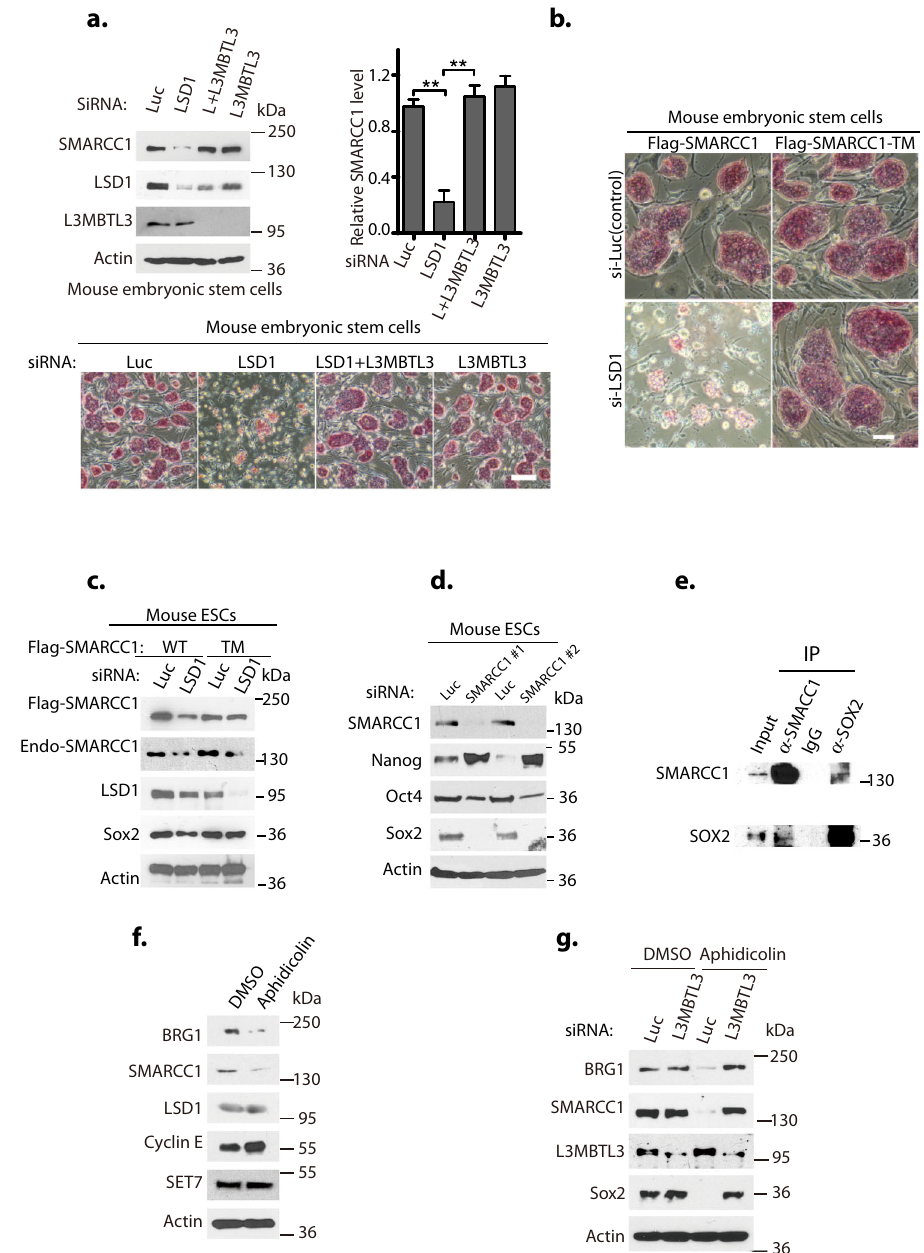
Fig.5|SMARCC1isacriticaltargetofLSD1inmouseESCs.a L3MBTL3silencing stabilizesSMARCC1inmouseembryonicstemcells.ThemESCsweretransfected with50nMof luciferase,LSD1, LSD1 +L3MBTL3,andL3MBTL3siRNAsfor40h. Representation from threeindependentexperimentsisshownforthe levelsof SMARCC1, LSD1,L3MBTL3, and actinexamined byWestern blotting and quan- titativelyanalyzed.Signi fi cancewasindicatedasatwo-tailed,unpaired, t -testfor a .Values are expressed asthe mean± SEM. ** p < 0.01. b , c The SMARCC1 triple mutant confers resistance to LSD1 silencing. The mESCsstably expressing the wildtype and the K201R/K482R/K615R triple mutant of Flag-SMARCC1 were transfected with 50nM siRNAs of luciferaseorLSD1for40h,stained with alka- linephosphatase(AP),andcellimageswereacquired( b )withNikonECLIPSETi-S microscope equipped withNIS-Elements BR 3.1